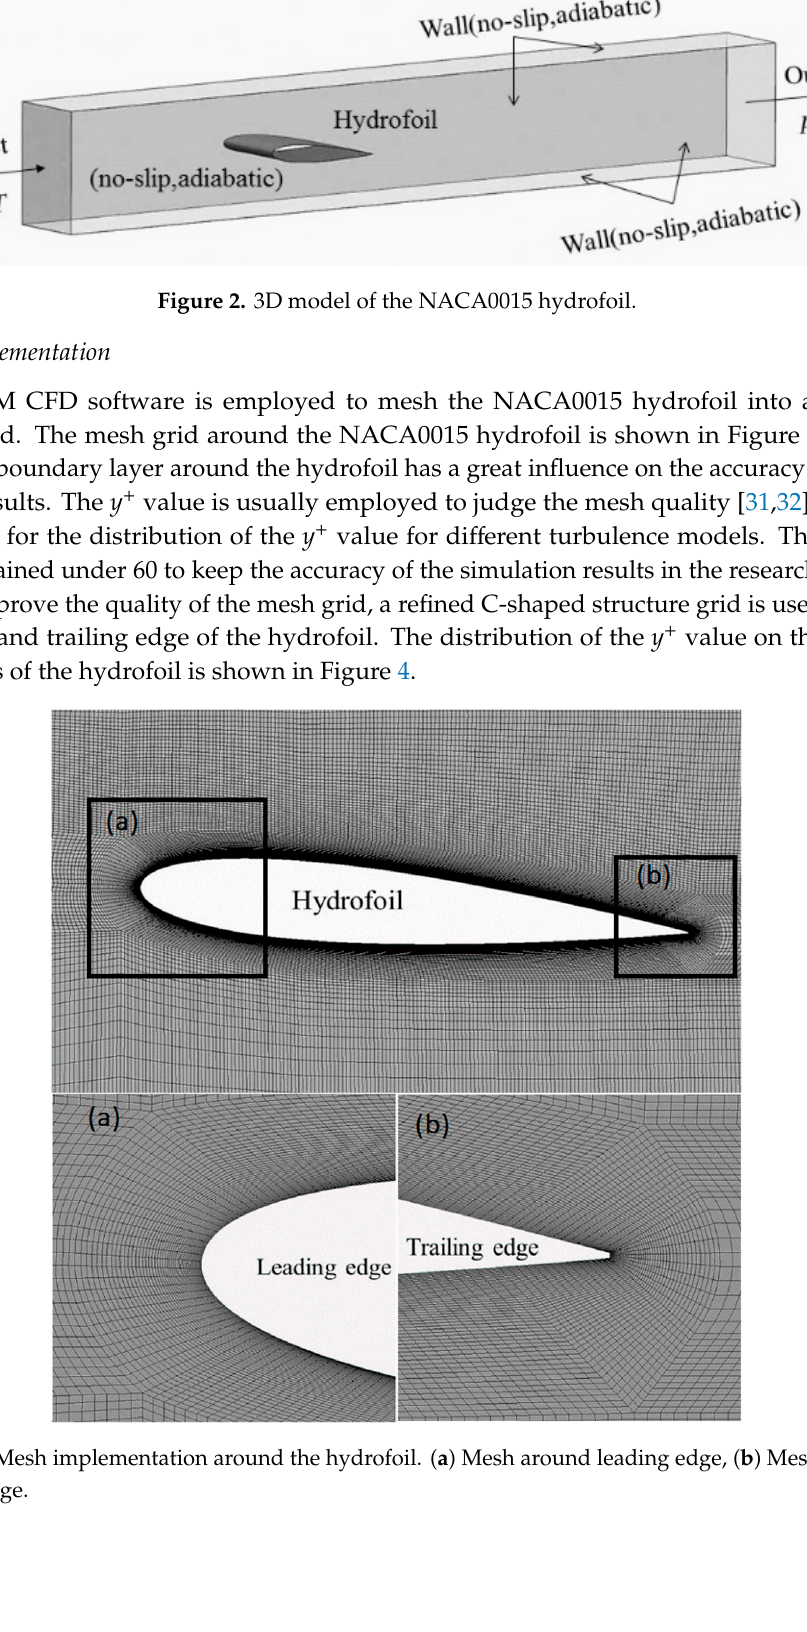
Figure 1. Schematic illustration of the experimental section.